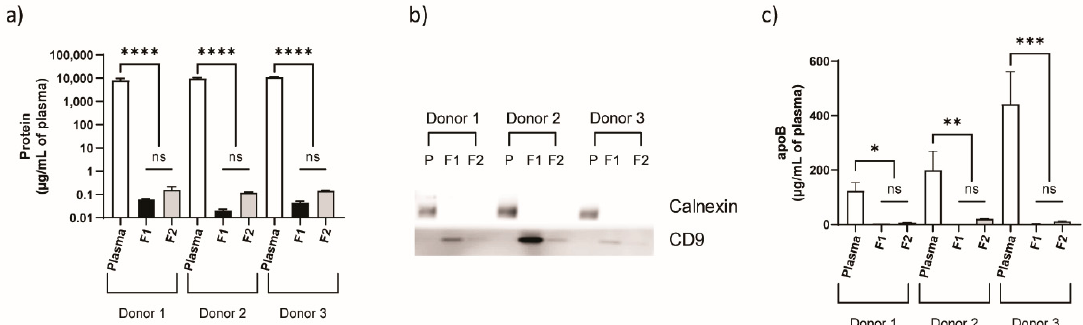
Figure 4. Protein markers of plasma-derived EVs. ( a ) Protein concentration for each sample normalized to 1 mL of original plasma. ( b ) Western blot of cluster of differentiation 9 (CD9) (EV marker) and calnexin (contaminant marker). P is plasma. ( c ) Enzyme linked immunosorbent assay (ELISA) for apolipoprotein B (apoB). Data represent mean ± s.d. ( n = 3) Statistics by one-way analysis of variance (ANOVA). * p < 0.025; ** p < 0.004; *** p < 0.0007; ****, p < 0.0001; ns, not significant.